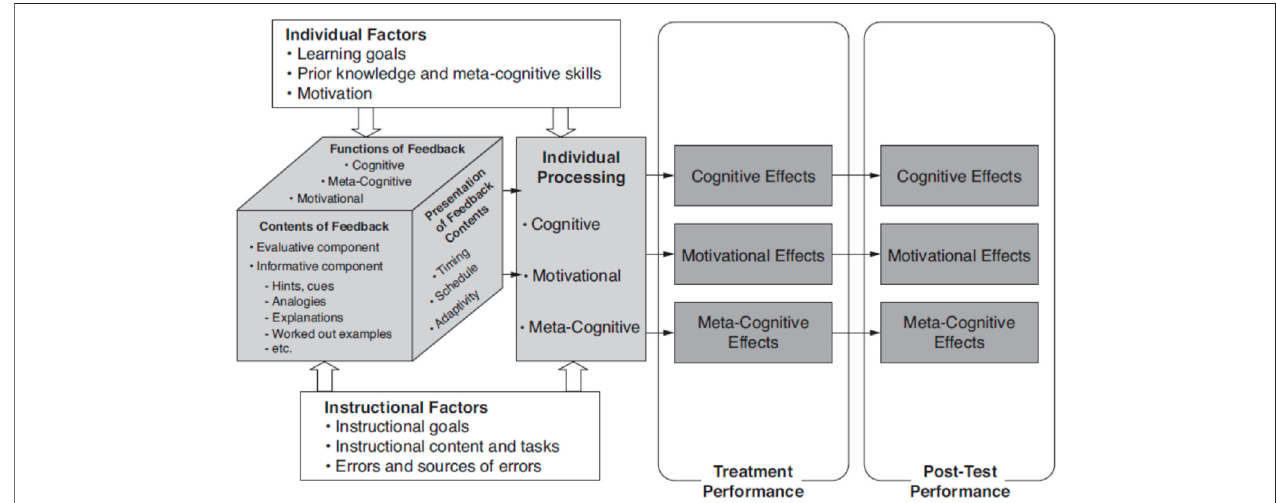
FIGURE 9 | Narciss (2008) model of factors and effects of external feedback.